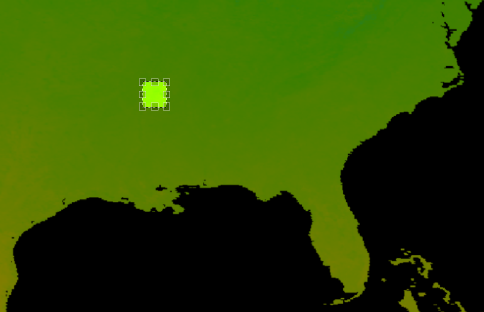
Figure 5. The square shows the area in USA from which we obtained our images of 140 × 140 pixels, with resolution (per pixel) of 1 km.